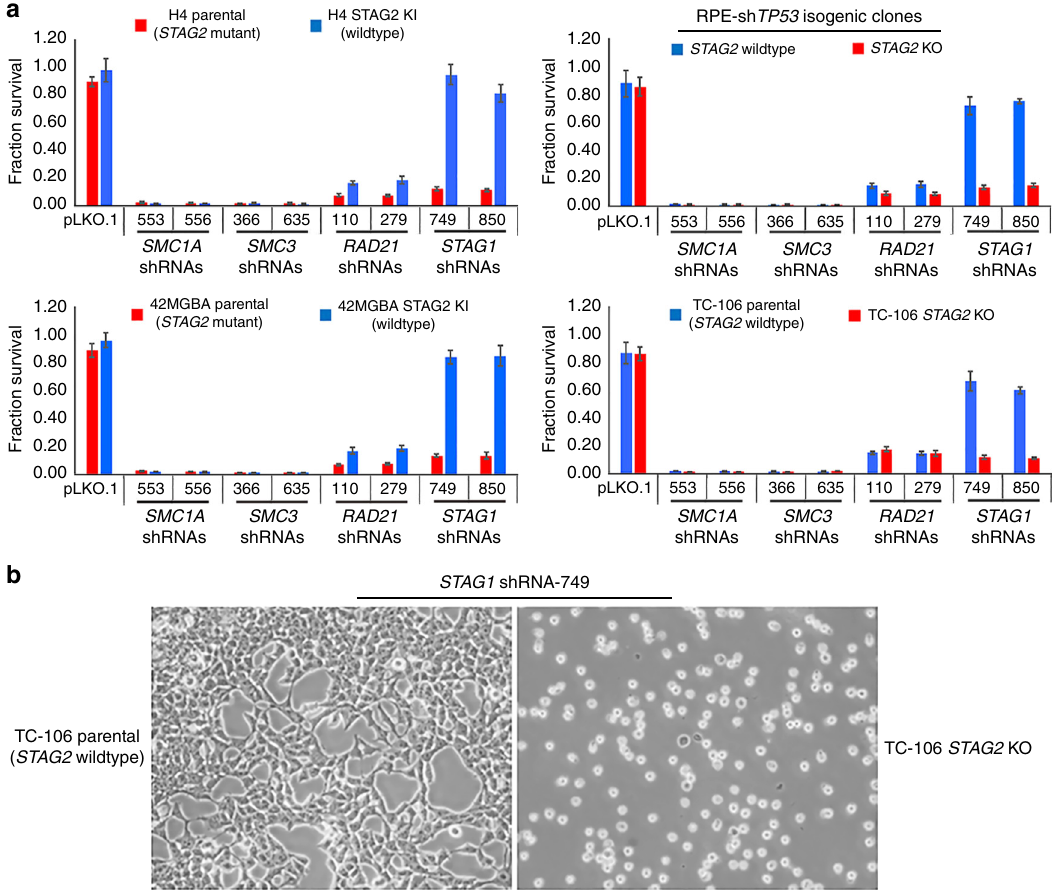
Fig. 6 STAG2 de fi ciency in human cancer cells creates a synthetic lethality with STAG1 , whereas the core cohesin subunits SMC3 , SMC1A , and RAD21 are required genes in human cancer cells independent of STAG2 status. a Quantitation of survival from lentiviral shRNA depletion of core cohesin subunits in four pairs of STAG2 isogenic human cells (H4 glioblastoma, 42MGBA glioblastoma, TC-106 Ewing sarcoma, and RPE sh TP53 ). Each data point is the mean of 8 replicates from 2 independent experiments, and error bars show standard error of the mean. b Representative phase contrast images of STAG2 isogenic TC-106 Ewing sarcoma cells showing synthetic lethality of STAG2 inactivation with shRNA depletion of